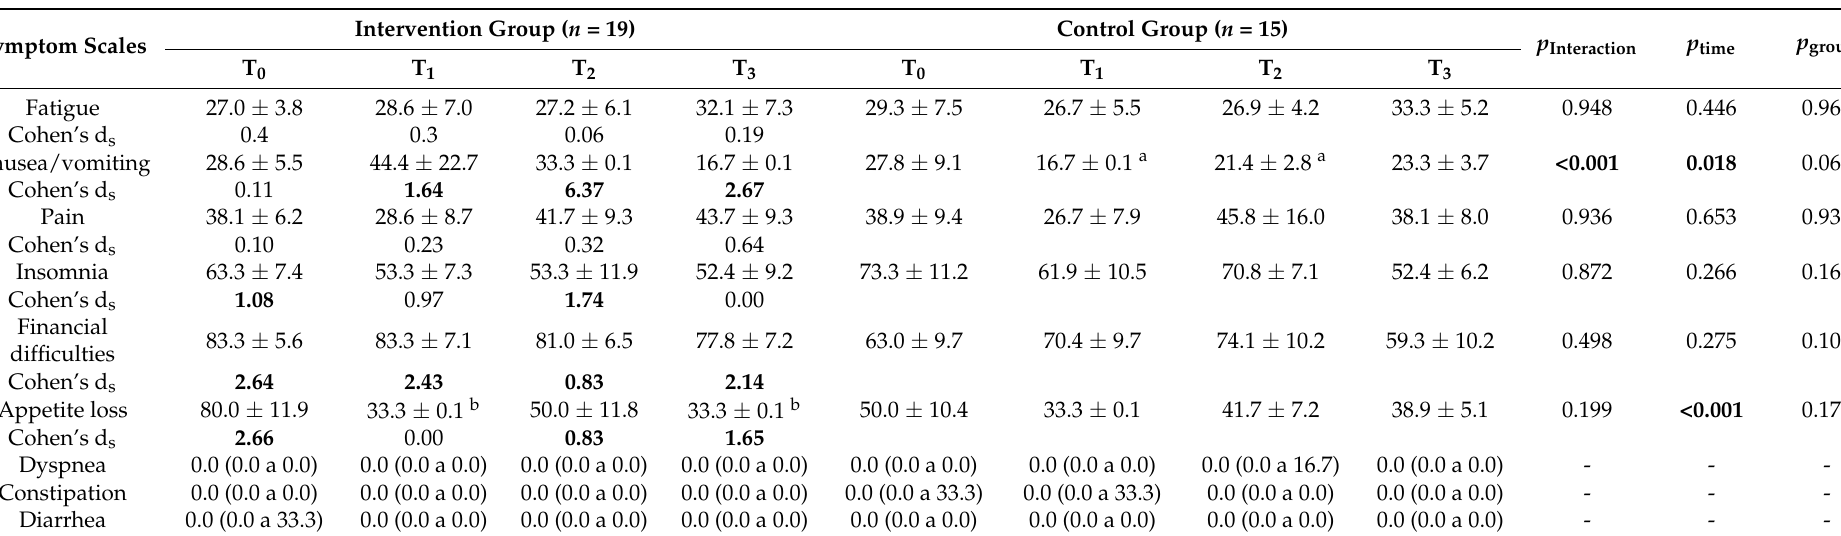
Table 3. Comparison of symptom scales by the EORTC QLQ-C30 between the nutritional intervention group and the control group in the pre-chemotherapy period and in the first three cycles of neoadjuvant